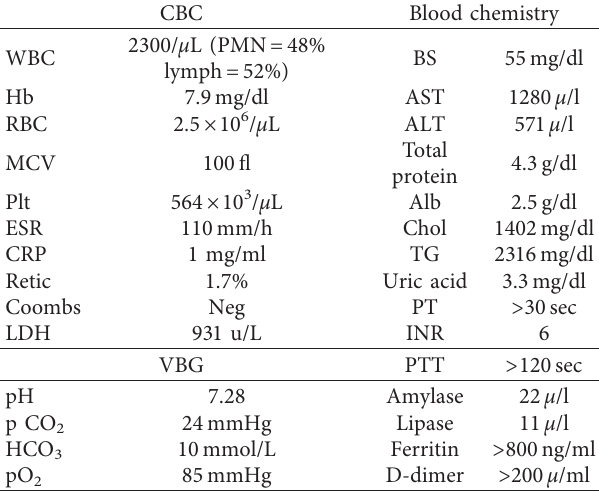
Table 1: Laboratory findings of the